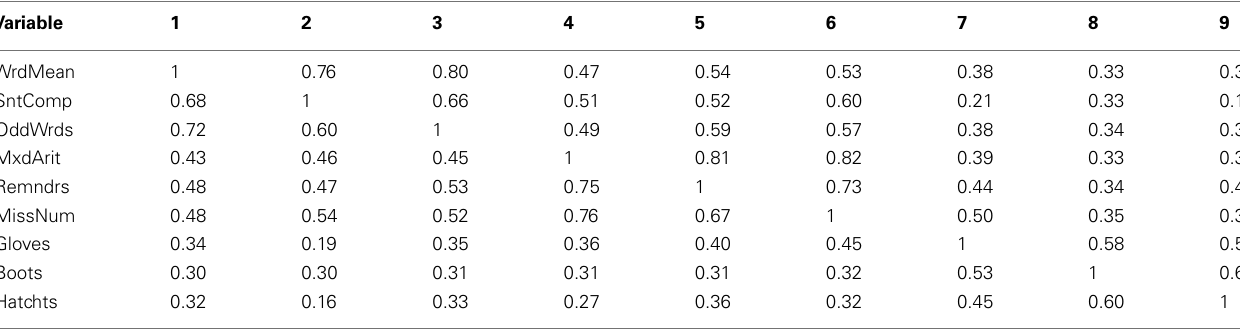
Table 7 | Product-moment and polychoric correlations among Case 2 item-level